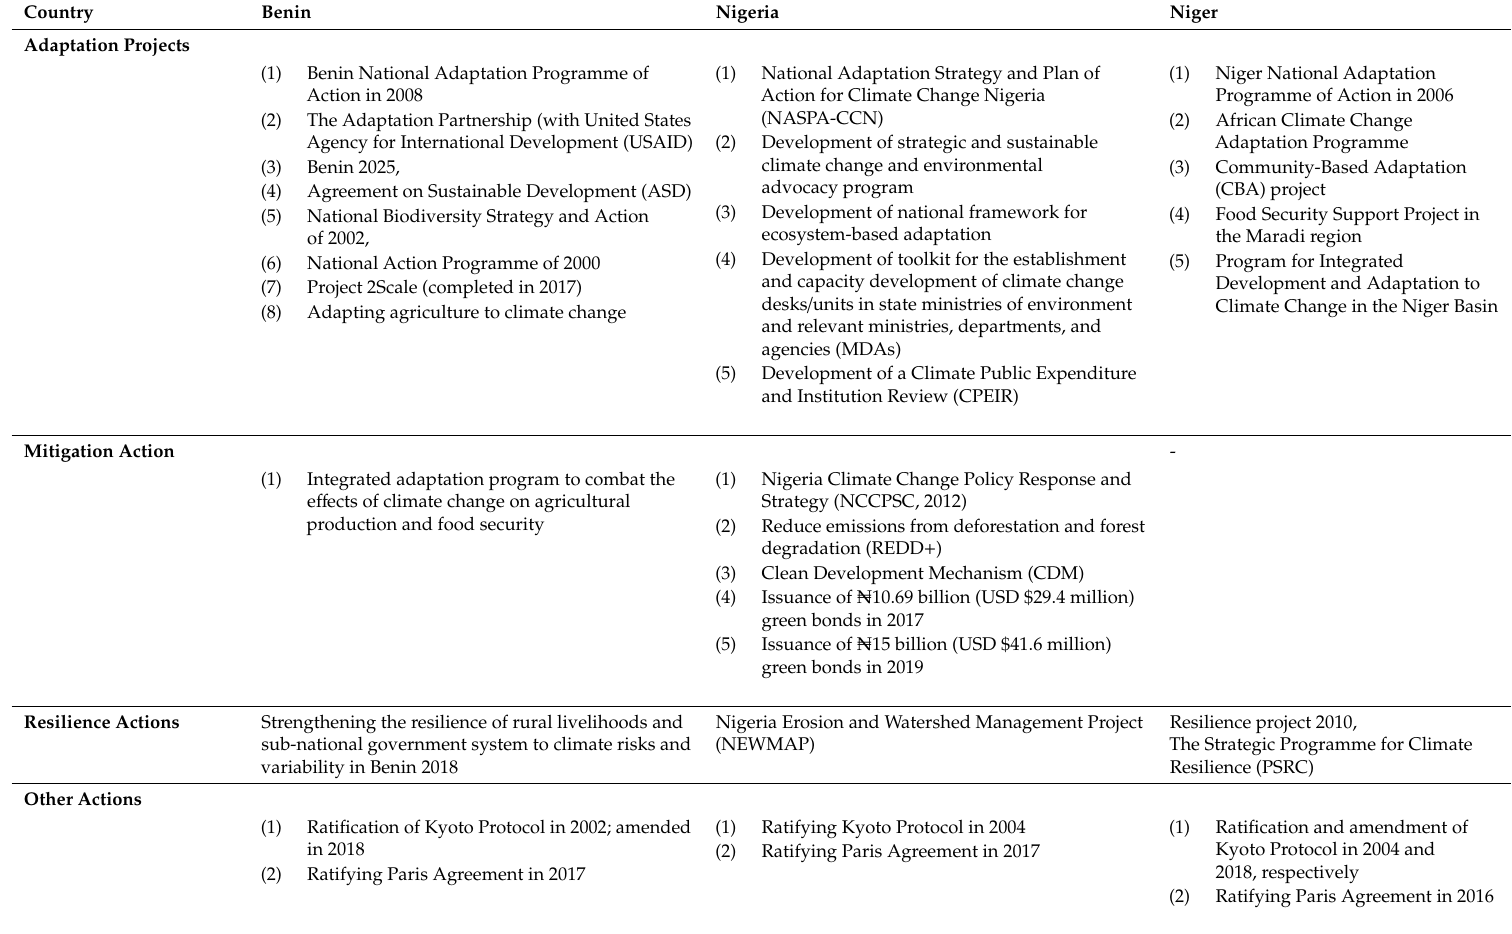
Table 1. Some climate actions in the selected countries in collaboration with international